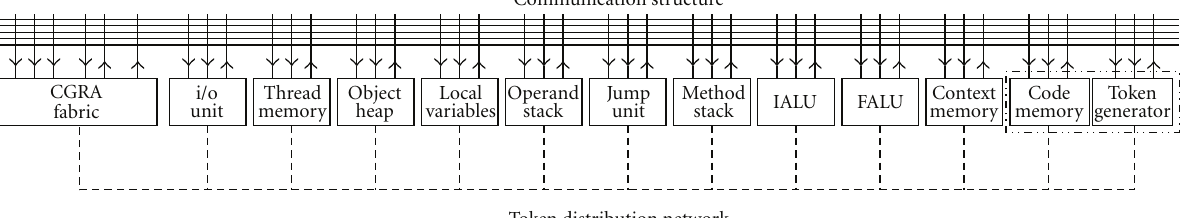
Figure 2: Model of a Java (non-)virtual machine on AMIDAR basis.